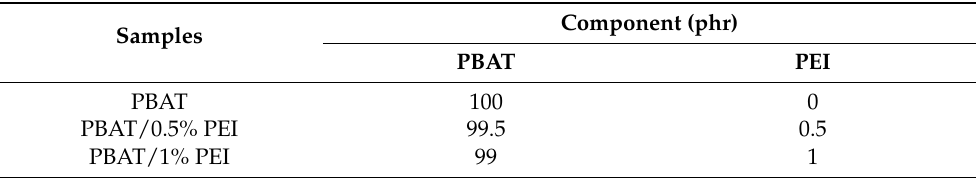
Table 1. Composition of PBAT